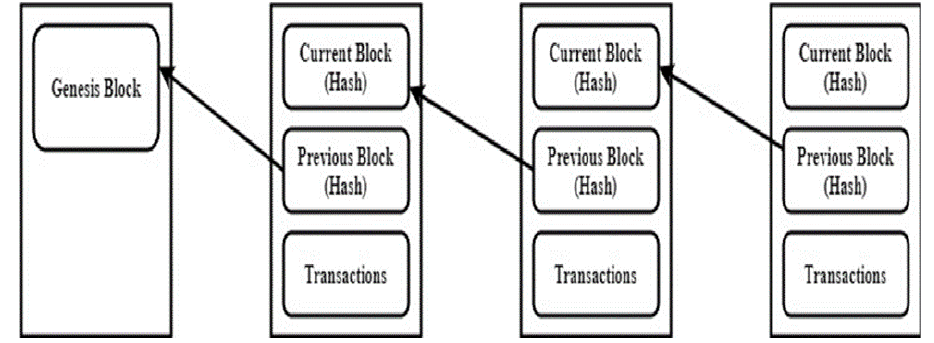
Figure 1. Blockchain